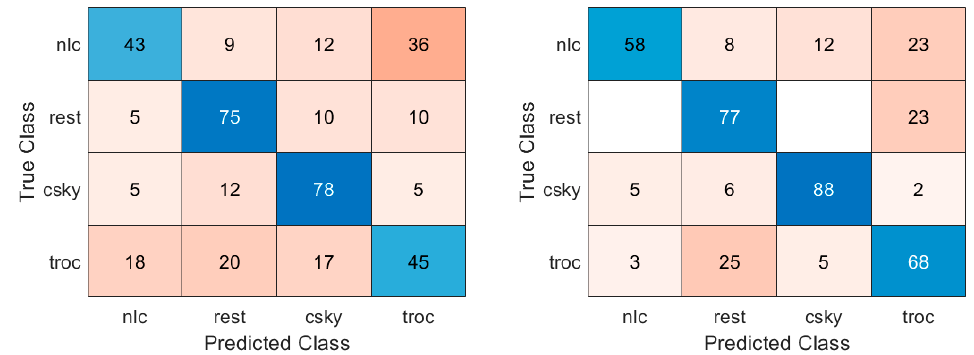
Figure 8. Confusion matrices for the four categories when using mean only (on the left) and using mean and standard deviation (on the right).